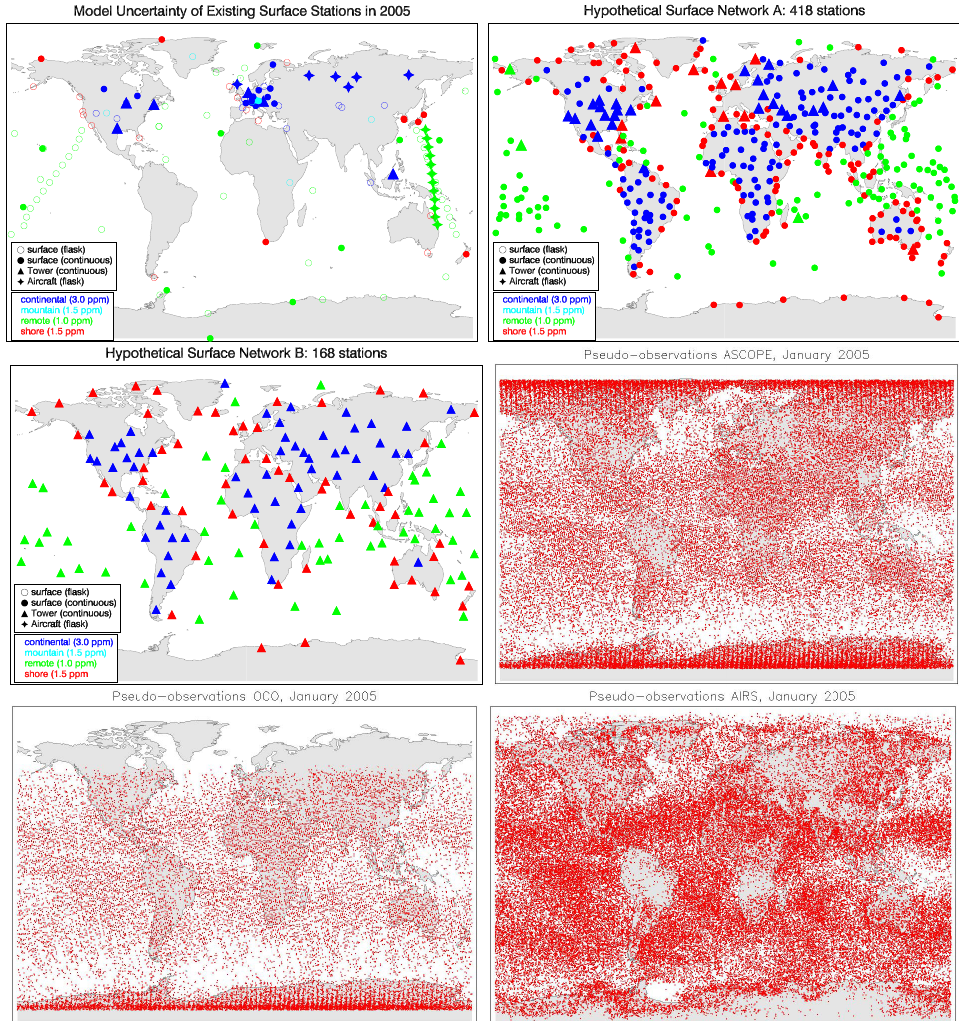
Fig. 2. (a) Geographical location of the existing surface stations in 2005. Different symbols are used to separate between the various measurement techniques, colours are indicative for the error associated with each station as mentioned in Sect. 3. Assumptions about the temporal sampling are described in Sect. 3. (b) Geographical location of the hypothetical network A. (c) Geographical location of the hypothetical network B. (d–f) clear-sky measurements of (d) A-SCOPE-2.0, (e) OCO and (f) AIRS in January